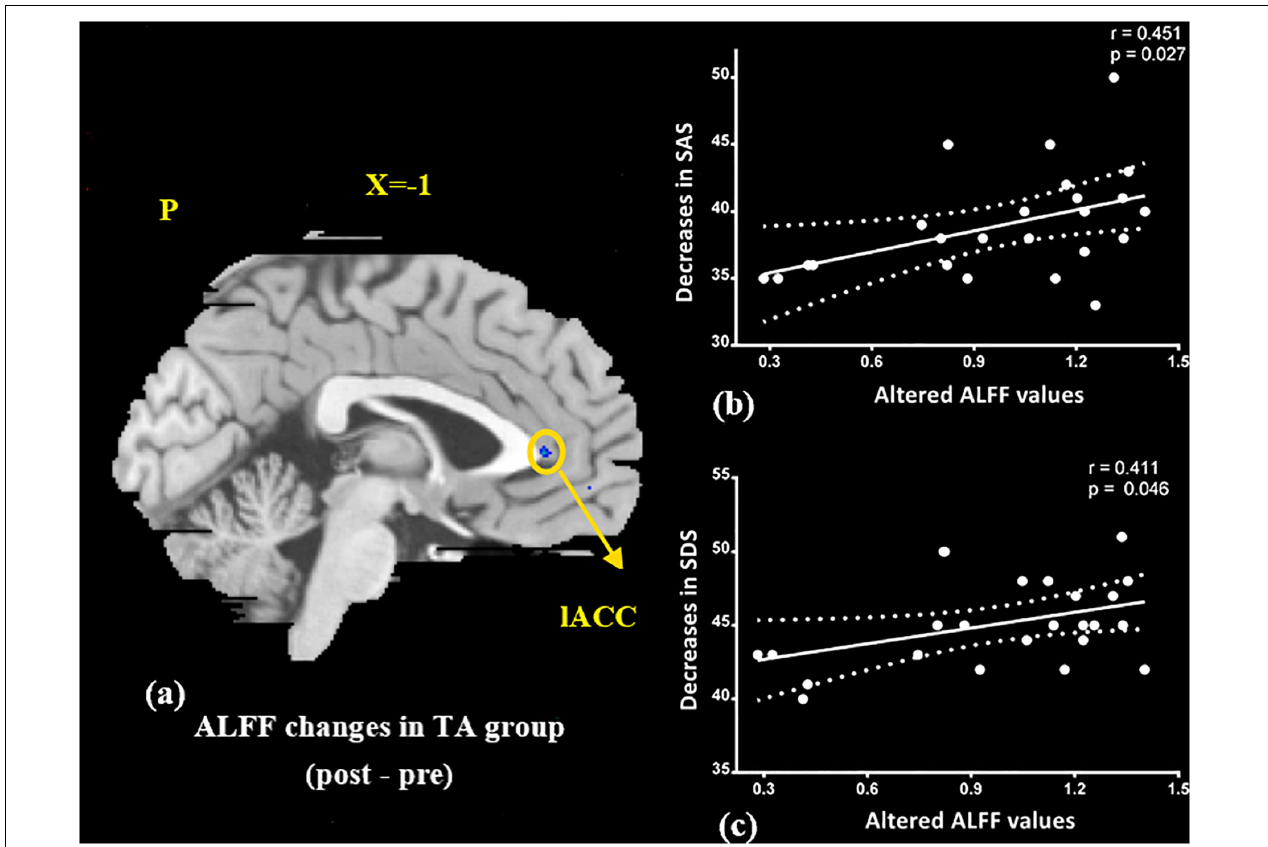
FIGURE 5 | Correlation analysis between altered ALFF values in ACC and improvements in the SAS, SDS in the TA group ( p < 0.05, FDR corrected). (a) Brain region used for the correlation analysis shown. (b) ALFF in the ACC was positively correlated with SAS. (c) ALFF in the ACC was positively correlated with SDS. ACC, anterior cingulate; L, left; P, posterior; SAS, Zung self-rating anxiety scale; SDS, Zung self-rating depression scale; TA, true